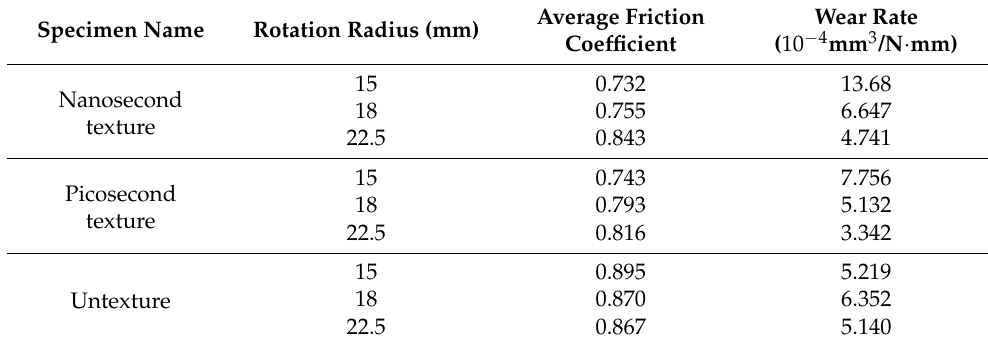
Table 5. Friction coefficient and wear rate.